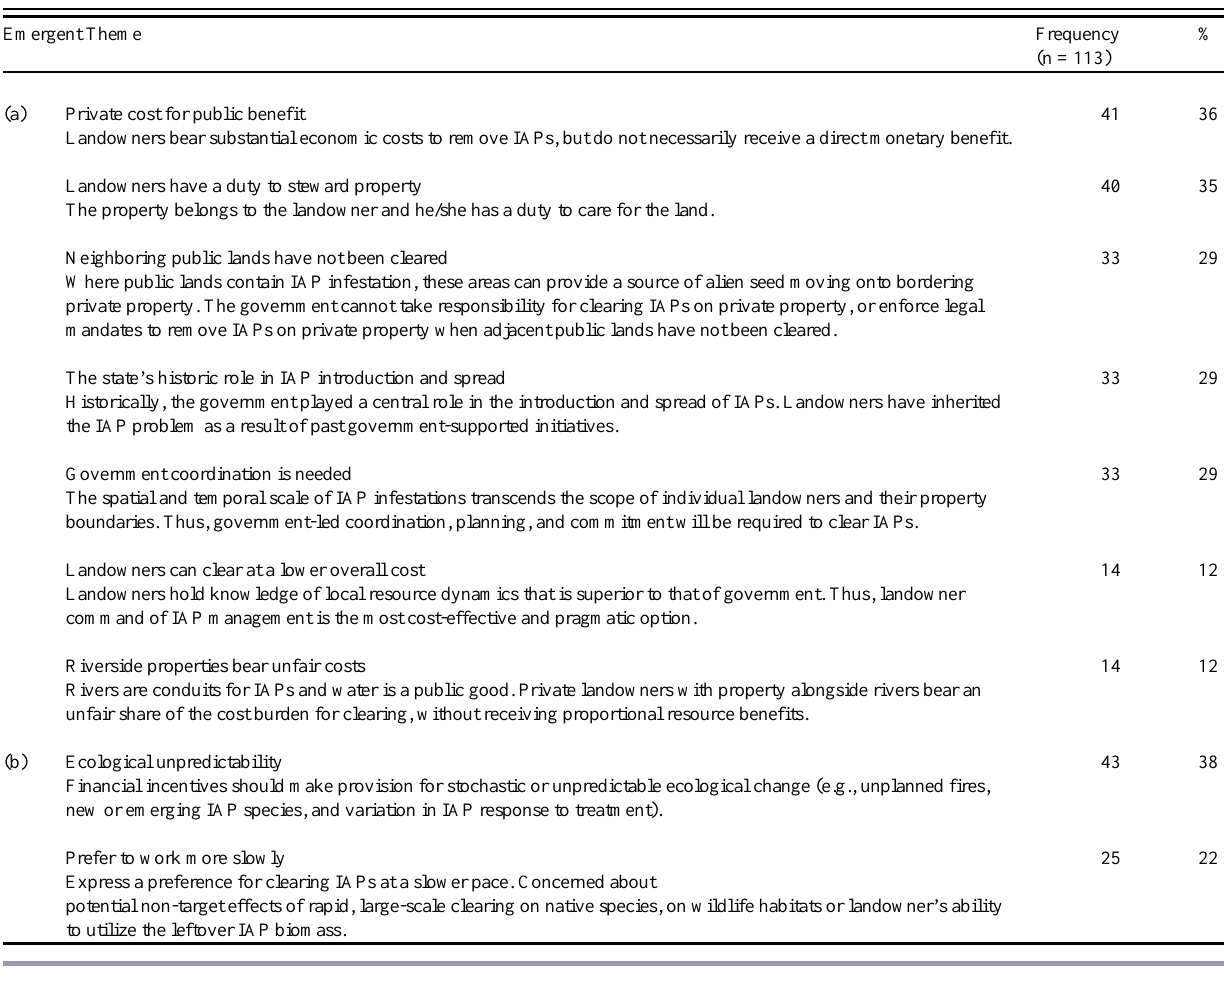
Table 6 . Emergent themes based on landowner responses to open-ended interview questions regarding (a) landowner and government responsibility for clearing invasive alien plants (IAPs); and (b) the quantity and duration of financial assistance proposed in WfW’s approach to clearing IAPs on private land, Western Cape. Only themes showing a significant association with landowner study site or landowner responses to closed-ended questionnaire items are presented (see Table